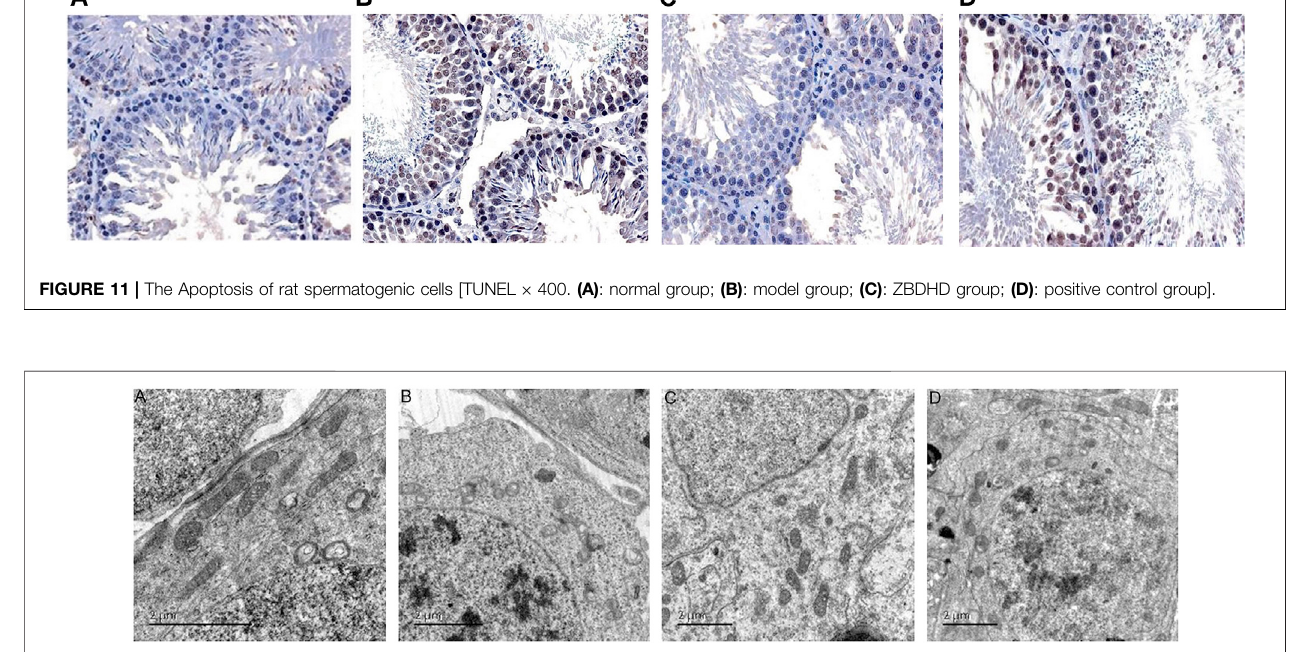
FIGURE 12 | The ultrastructure of rat spermatogenic cell mitochondria [ × 12,000 (A) : normal group; (B) : model group; (C) : ZBDHD group; (D) : positive control group].